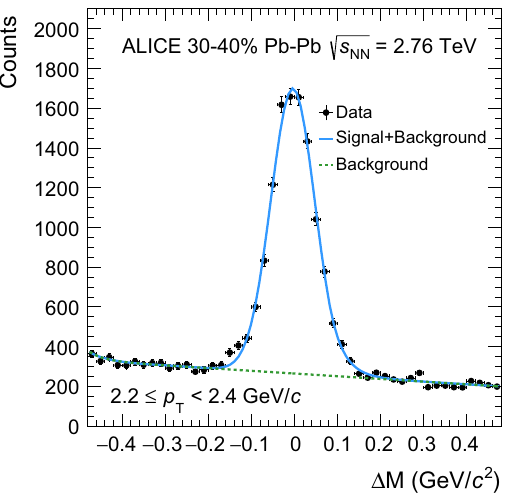
Fig. 4 Left: Distribution of (cid:14) M for d+d in the 2 . 2 ≤ p T < 2 . 4 GeV / c and centrality interval 30–40% fitted with a Gaussian with an exponen- tial used to reproduce the signal and an exponential to reproduce the